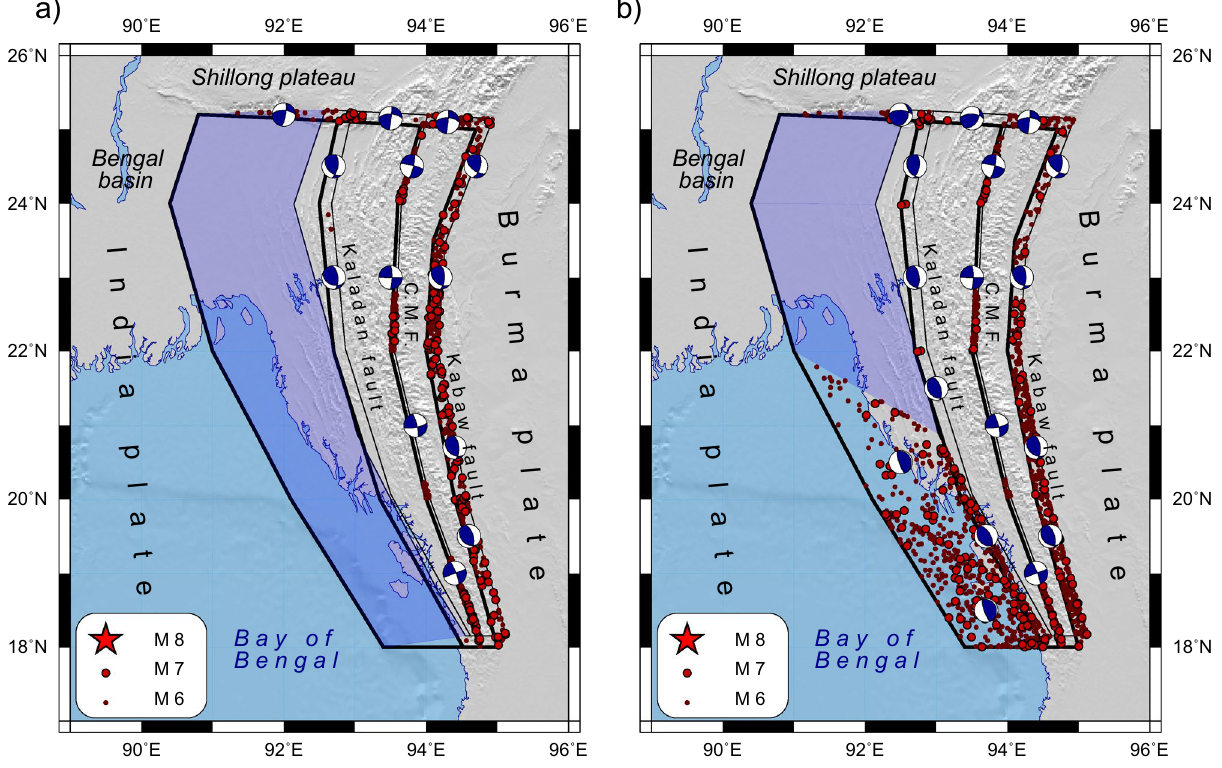
Figure 5. Map of synthetic seismicity simulated for 20 thousand years: ( a ) EX2 “IBD unlocked”; ( b ) EX3 “Tripura unlocked”. Unlocked segments are highlighted by transparent blue; other notations are like in Fig.